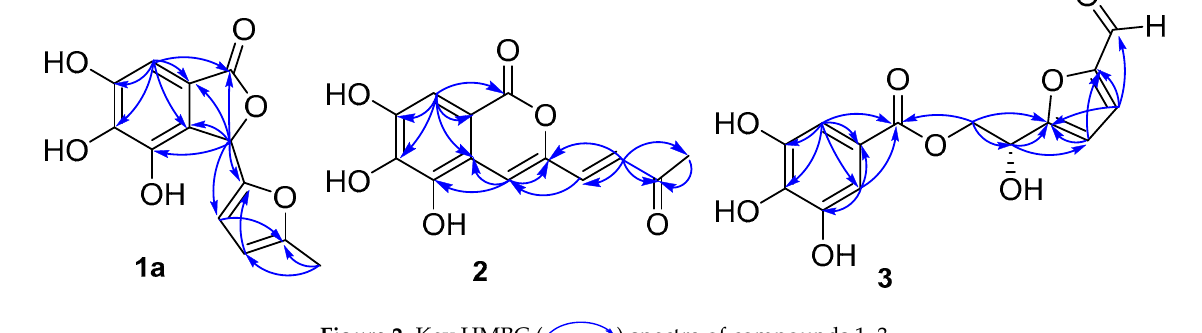
Figure 2. Key HMBC ( ) spectra of compounds 1–3. Compound 1, [ α ] = 0 (c 0.080, MeOH), is a racemix mixture of a pair of enantiomers (1a and 1b), which could undergo rapid interconversion at room temperature. Thus, while performing the chiral separation, their optical rotation and ECD spectra were measured. Compound 1 was treated by normal phase chiral semipreparative column to obtain compounds 1a and 1b. A suitable crystal for X-ray diffraction experiment with Cu-K α radiation was obtained from MeOH after careful recrystallization to further determine the structure. Compound 1 of CCDC deposition numbers is 2047961. Crystal Data for C 13 H 10 O 6 ·H 2 O ( M = 280.23 g/mol) is as follows: monoclinic, space group P2 1 /n (no. 14), a = 10.851 Å, b = 4.199 Å, c = 26.533 Å, β = 92.00, V = 1208.2 Å 3 , Z = 4, T = 170.0 K, μ (CuK α ) = 1.094 mm -1 , Dcalc = 1.541 g/cm 3 , 7313 reflections measured (6.666 ≤ 2 Θ ≤ 133.512), 2058 unique ( Rint = 0.0498, Rsigma = 0.0436) which were used in all calculations. The final R1